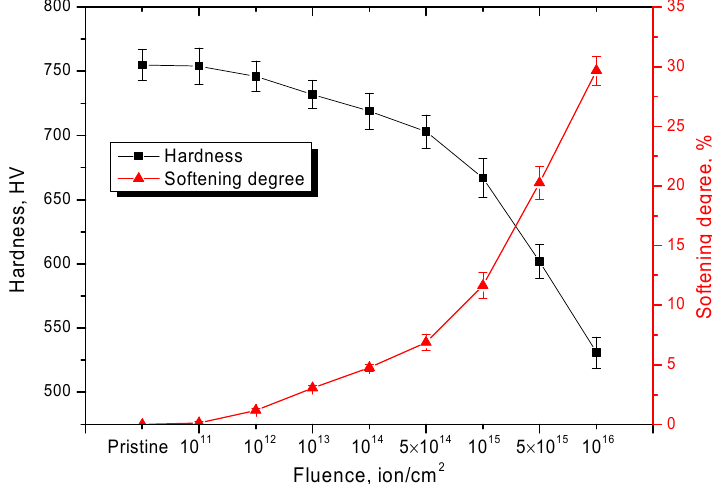
Figure 7. Data on changes in strength properties depending on irradiation fluence.